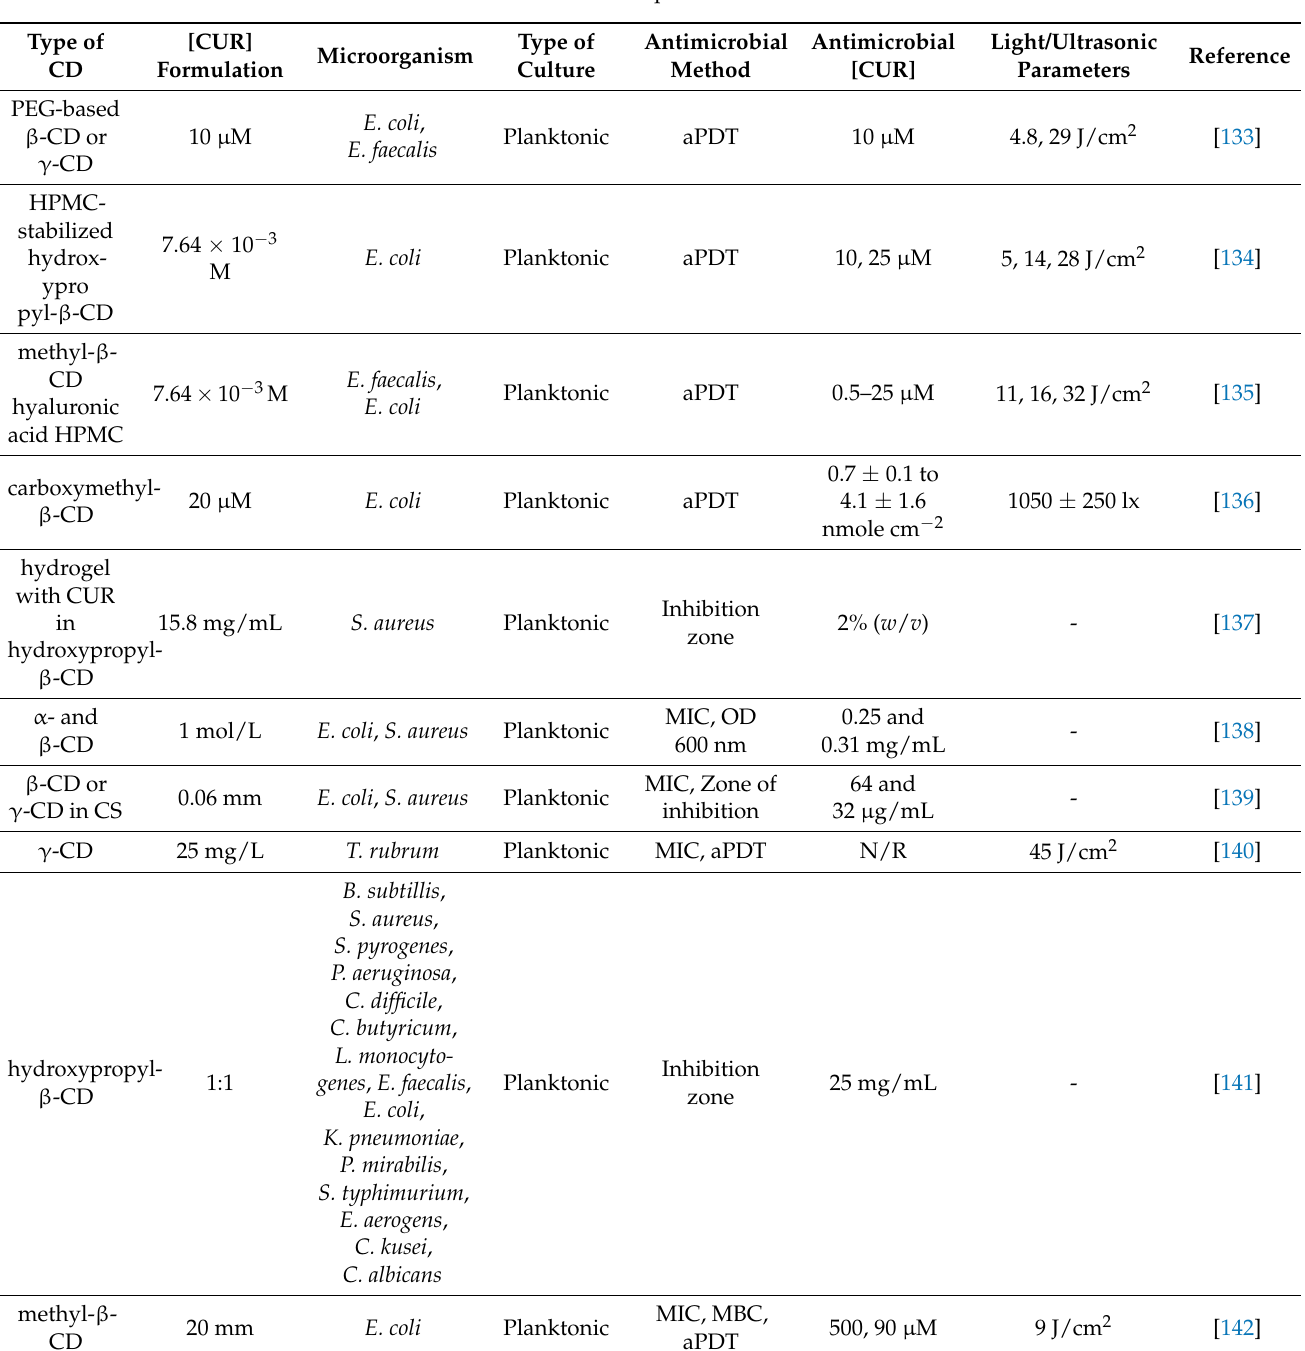
Table 5. Antimicrobial studies performed with CUR in